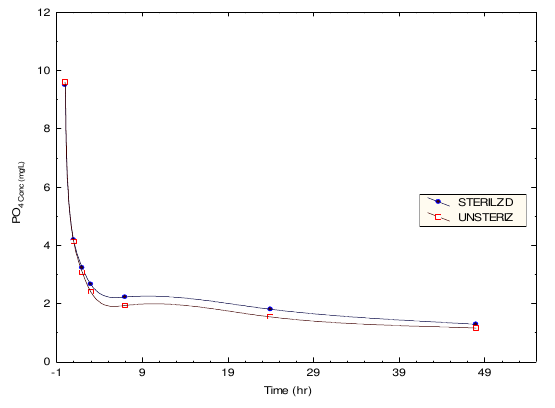
Fig. 12 . Effect of sterilization on the pollutant with time at concentration level of PO 4 T=25 o C, pH 7, wastewater/ (Algae broth) ratio =1.